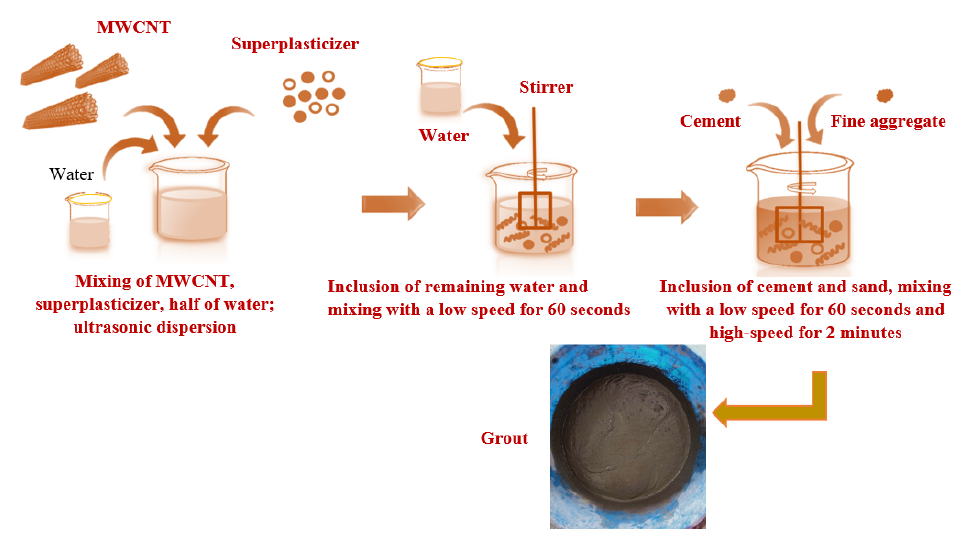
Figure 4. MWCNT mixing method to develop grout.